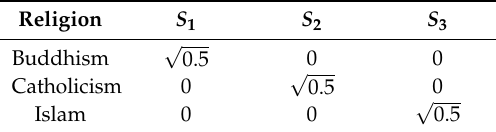
Table 2. Nominal attributes